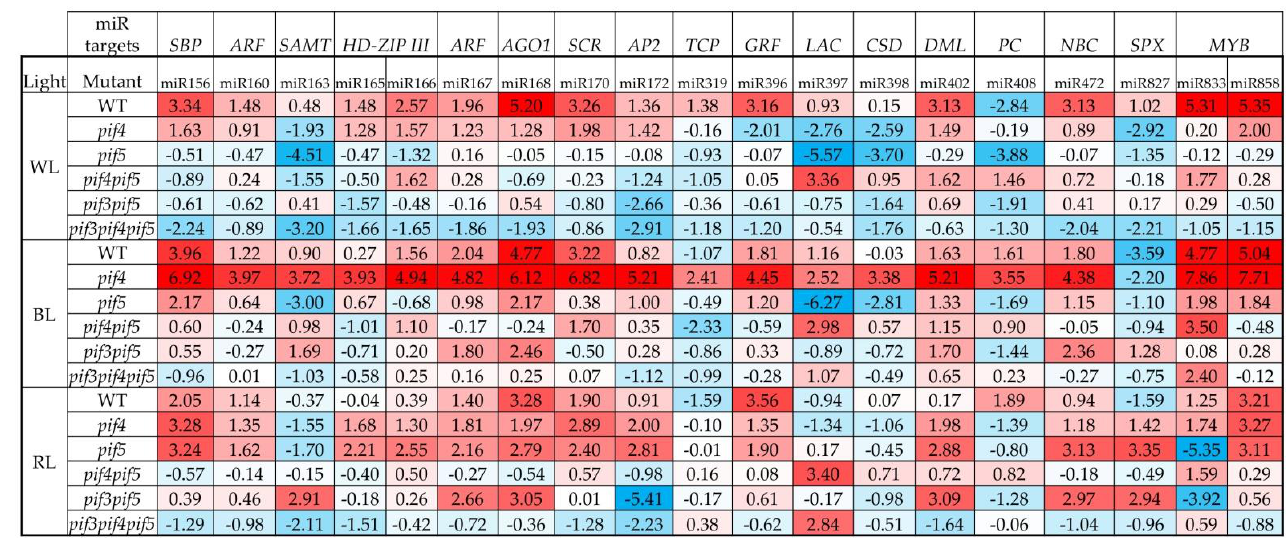
Figure 4. Effect of light with different spectra on the expression of light-dependent miRNAs in the WT and pif mutant 4-week-old A. thaliana plants. Log 2 data are presented. Changes were considered significant if the expression was above or below one ( p < 0.05; n = 3). MicroRNAs are marked with a black marker, which, according to the results of our studies, is dependent on PIF4 under the BL spectrum, and the expression of which changes in the pif5 mutant under the RL spectrum where the PIF4 protein is present. The top line of Figure 4 shows the target genes of the studied miRNAs (squamosa promoter binding proteins ( SBP ), auxin response factors ( ARF ), S-adenosyl- Met-dependent carboxyl methyltransferase ( SAMT ), HD-ZIP III transcription factor ( HD-ZIP III ), Argonaute protein 1 ( AGO1 ), GRAS domain or SCARECROW-like proteins ( SCR ), APETALA2 ( AP2 ), teosinte branched1/cycloidea/proliferating cell factor ( TCP ), growth-regulating factor ( GRF ), laccase ( LAC ), Cu/Zn superoxide dismutase ( CSD ), demeter-like protein ( DML ), plastocyanin ( PC ), CC-NBS- LRR gene family ( NBC ), SPX -domain-containing genes, nitrogen limitation adaptation (NLA) and phosphate transporter 5 (PHT5) ( SPX ), MYB transcription factors ( MYB